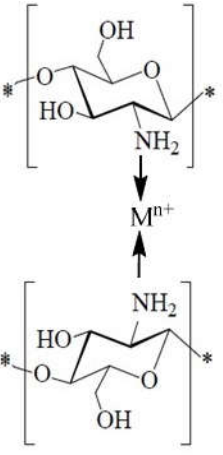
Figure 19. Schematic “bridge” model represented according to [112]. 2. The “pendant” model (Figure 20), in which the metal ion is coordinated with a single amino group [112]